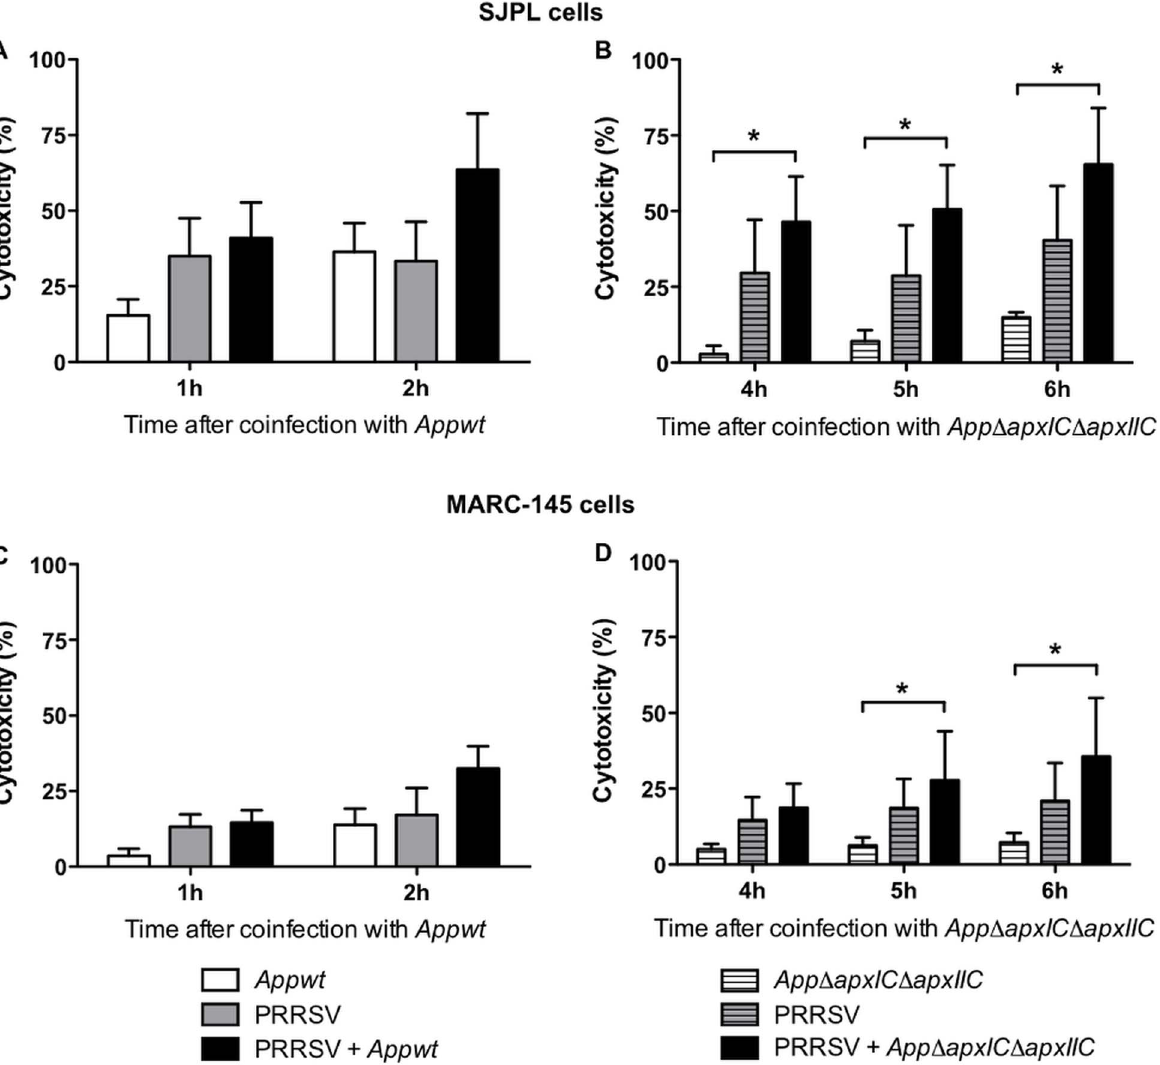
Figure 2. Cytotoxicity over time of Appwt or App D apxI D apxIIC in PRRSV co-infected SJPL and MARC-145 cells. SJPL (A and B) and MARC- 145 cells (C and D) were infected with or without PRRSV at an MOI of 0.5 during 72 hours, and then cells were co-infected with App (for 1 or 2 hours) (A and C, respectively) or with App D apxI D apxIIC (for 4, 5 and 6 hours) (B and D, respectively) at an MOI of 10. Cytotoxicity was measured in % using lactate dehydrogenase (LDH) CytoTox assay [20]. Values are presented as 6 Standard Deviation (SD). Two-away ANOVA analysis was used to obtain statistical data. * P , 0.05. All experiments were performed 3 times.